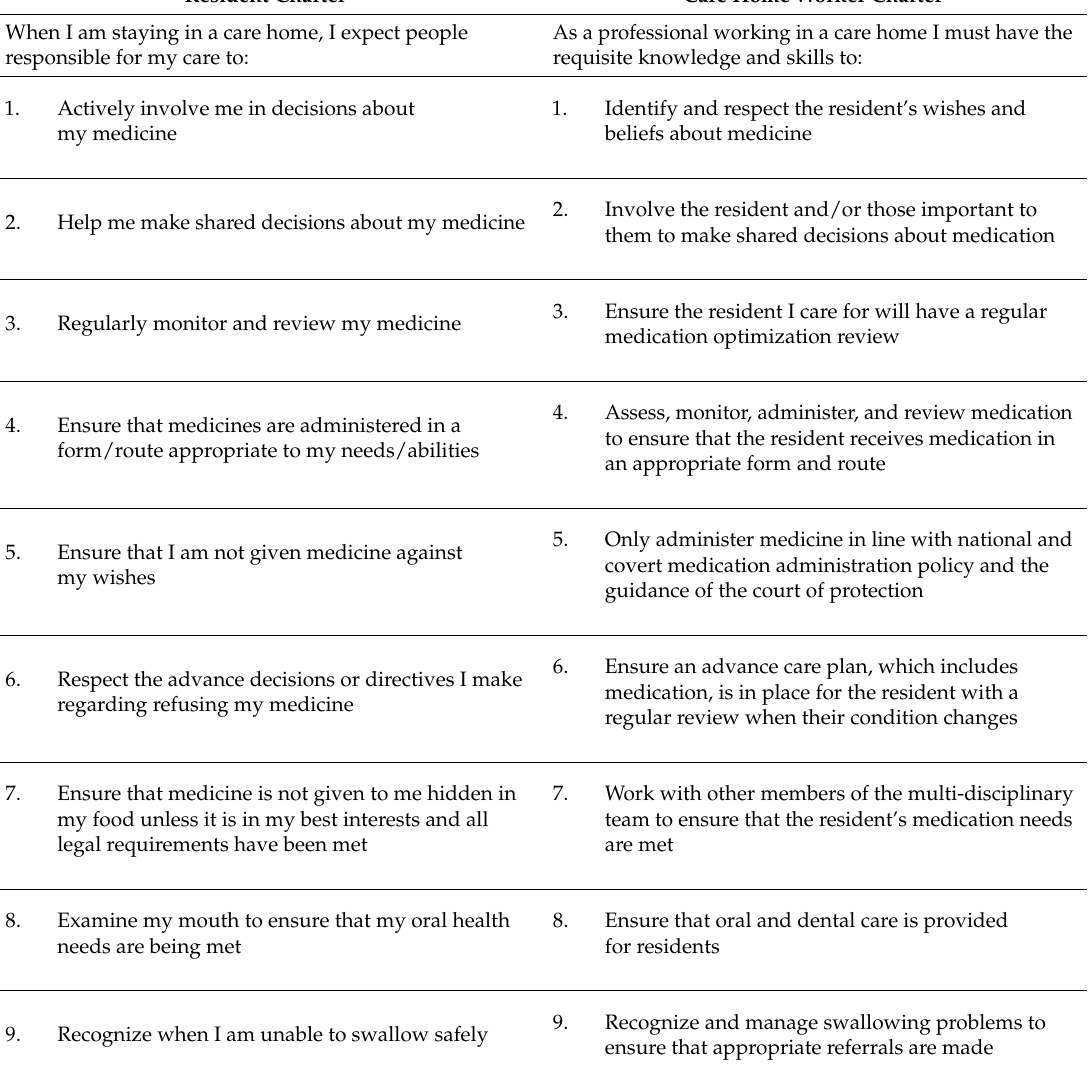
Table 1. Care Home Charter